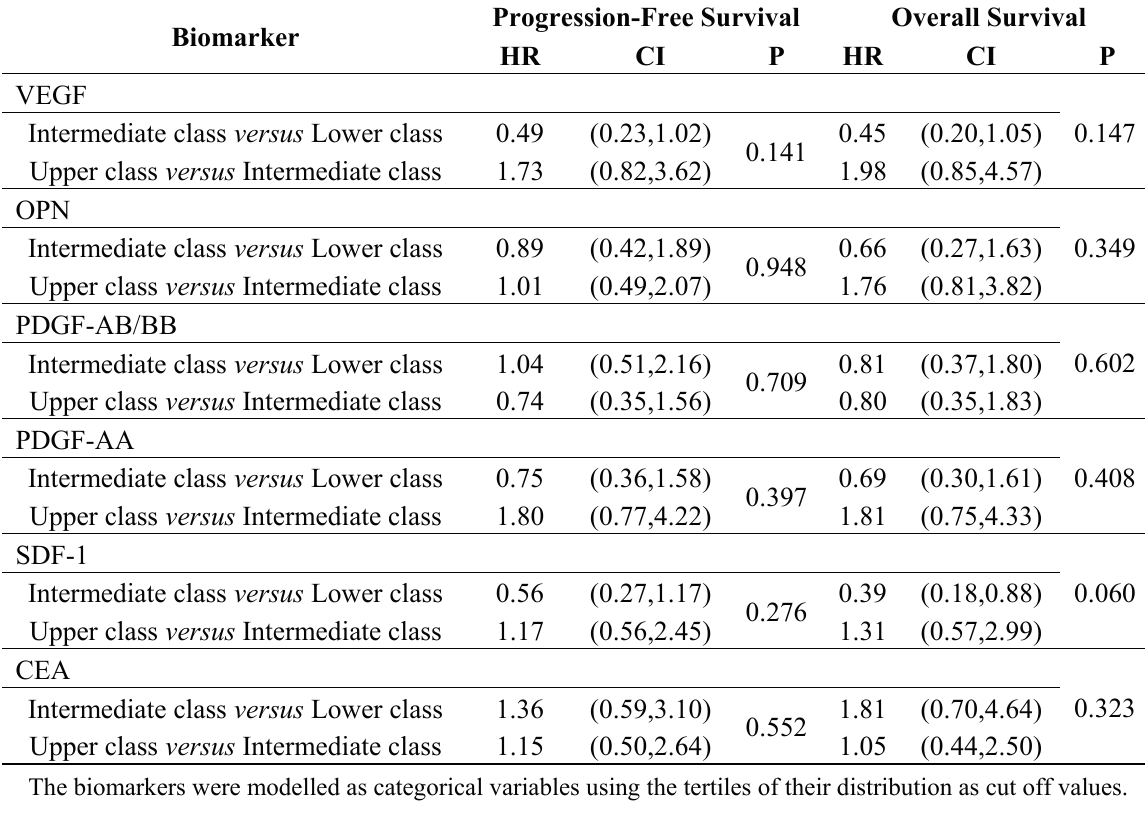
Table 4. Results from multivariable Cox models for studying the association between progression-free survival or overall survival and baseline biomarker